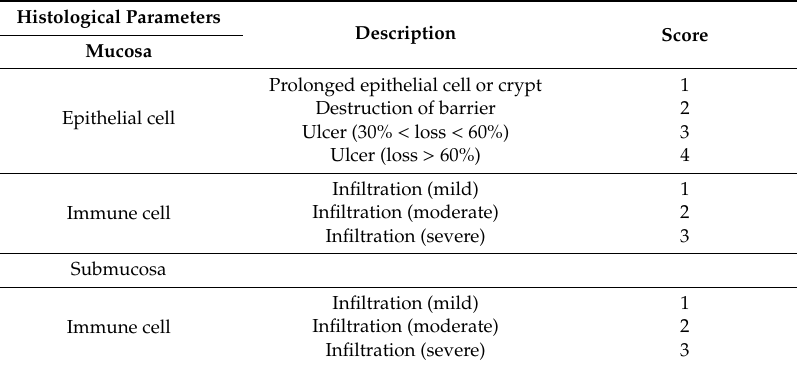
Table 2. Scores of histopathological